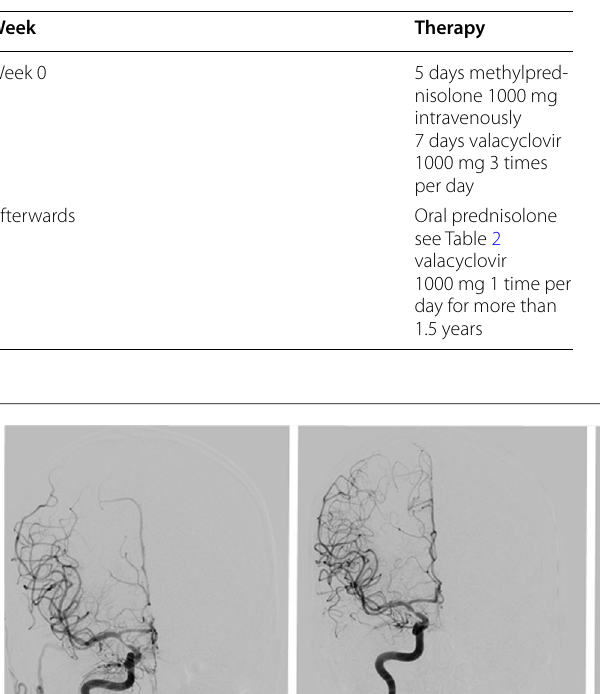
Table 1 Induction therapy in VZV vasculitis